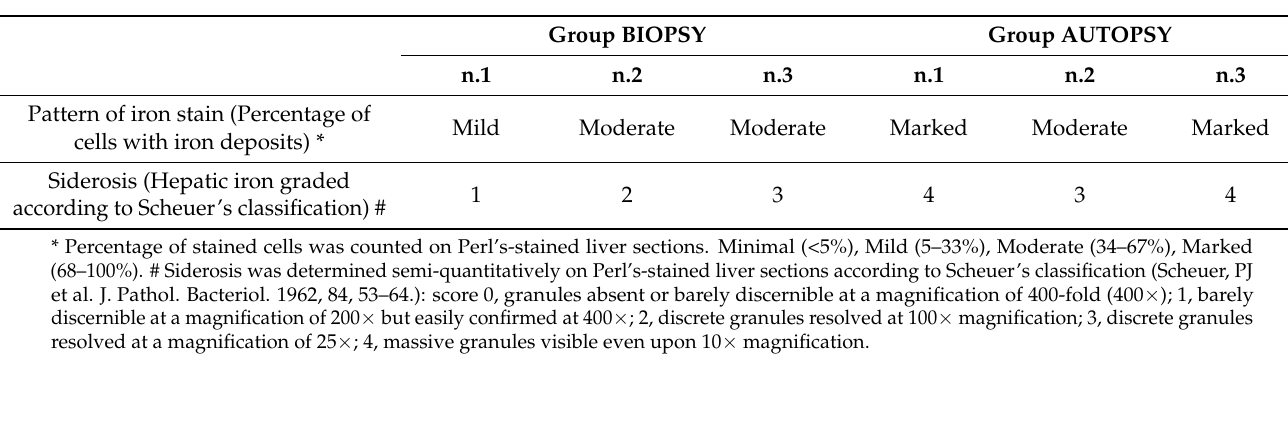
Figure 2. Immune-histochemical findings. ( A – D ) Immunostains of liver biopsies highlight the pres- ence of numerous CD8+ T lymphocytes ( A ); CD68 labelling highlights the presence of macrophages in the portal areas (arrow), and numerous Kupffer cells into sinusoids (arrowheads) ( B ). CD34 im- munolabeling shows a new angiogenesis process in periportal tracts ( C ) and centrilobular areas ( D ). ( E , F ) In autoptic liver sections, numerous CD8+ T lymphocytes are detected ( E ). CD34 positive stain- ing is present in endothelial cells of the portal tract vasculature, and extending beyond the periportal regions with centrizonal microvessels and sinusoids positivity ( F ). Scale bars: A,C,D – F = 50 µ m; B = 14 µ m. Table 5. Iron presence in the